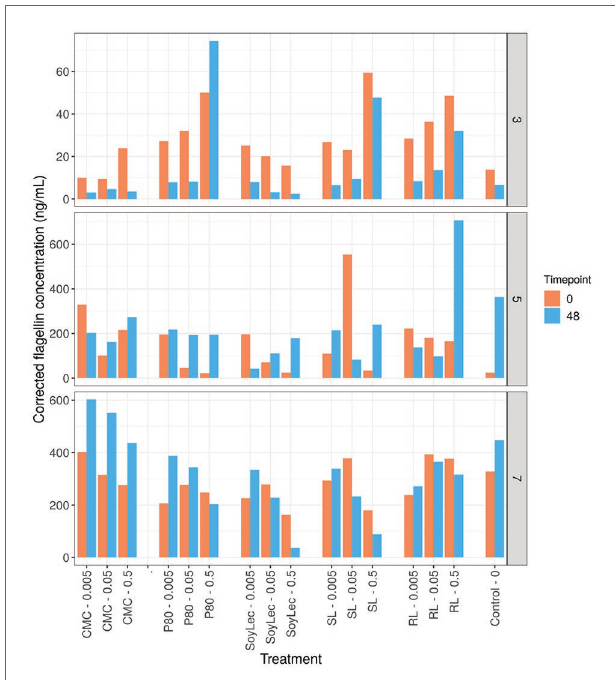
FIGURE 8 | Flagellin concentrations obtained using mTLR5 HEK blue reporter cells for three donors at the start (T0) and the end (T2) of in vitro 48 h batch experiments of fecal material from 10 donors in sugar depleted medium supplemented with five emulsifiers at four concentrations. Donors for the flagellin assay were selected based on their low (D3), high (D7), and intermediate (D5) metabolic responses to the